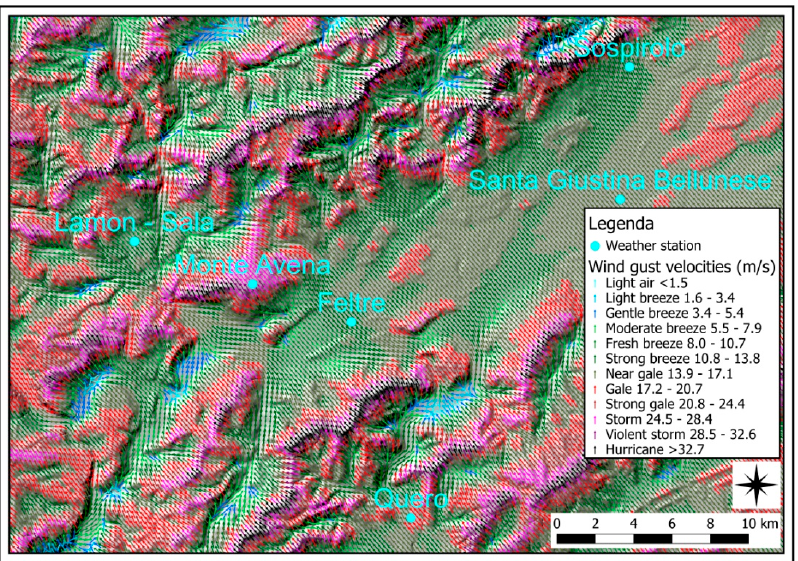
Figure 18. Wind gust modelling in the area.